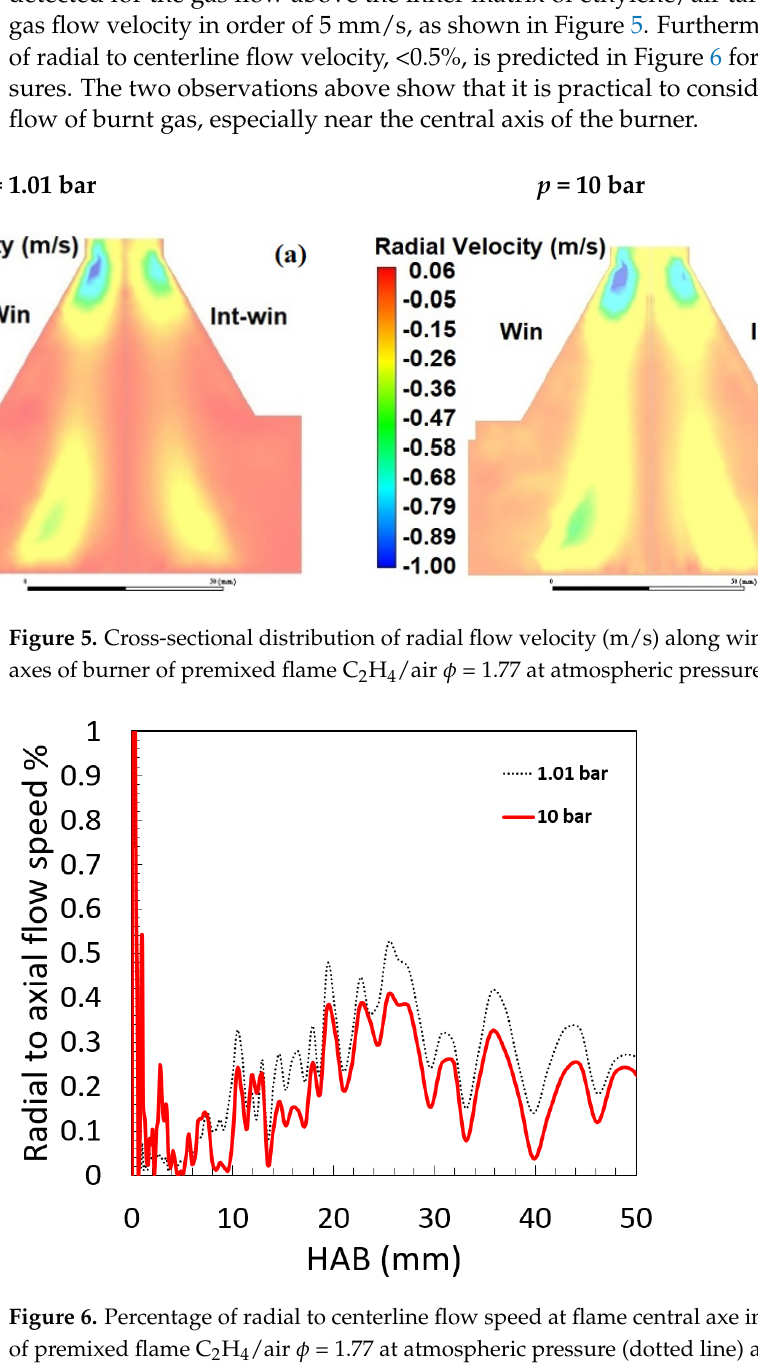
Figure 6. Percentage of radial to centerline flow speed at flame central axe in function of HAB (mm) of premixed flame C 2 H 4 /air ϕ = 1.77 at atmospheric pressure (dotted line) and 10 bar (solid line).